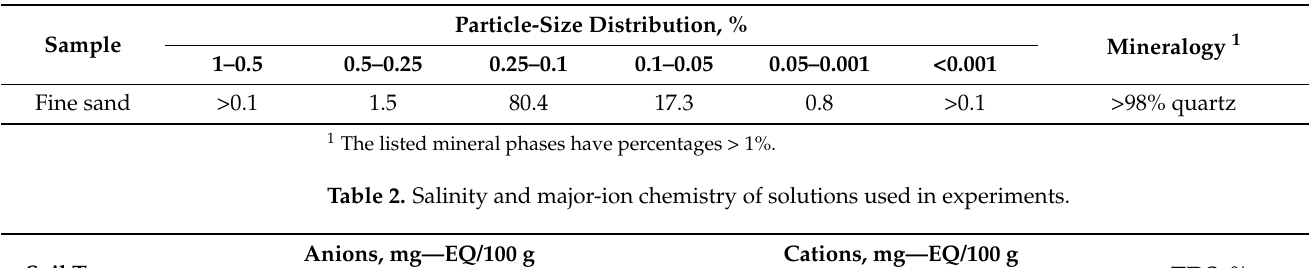
Table 1. Grain sizes and mineralogy of sand samples.